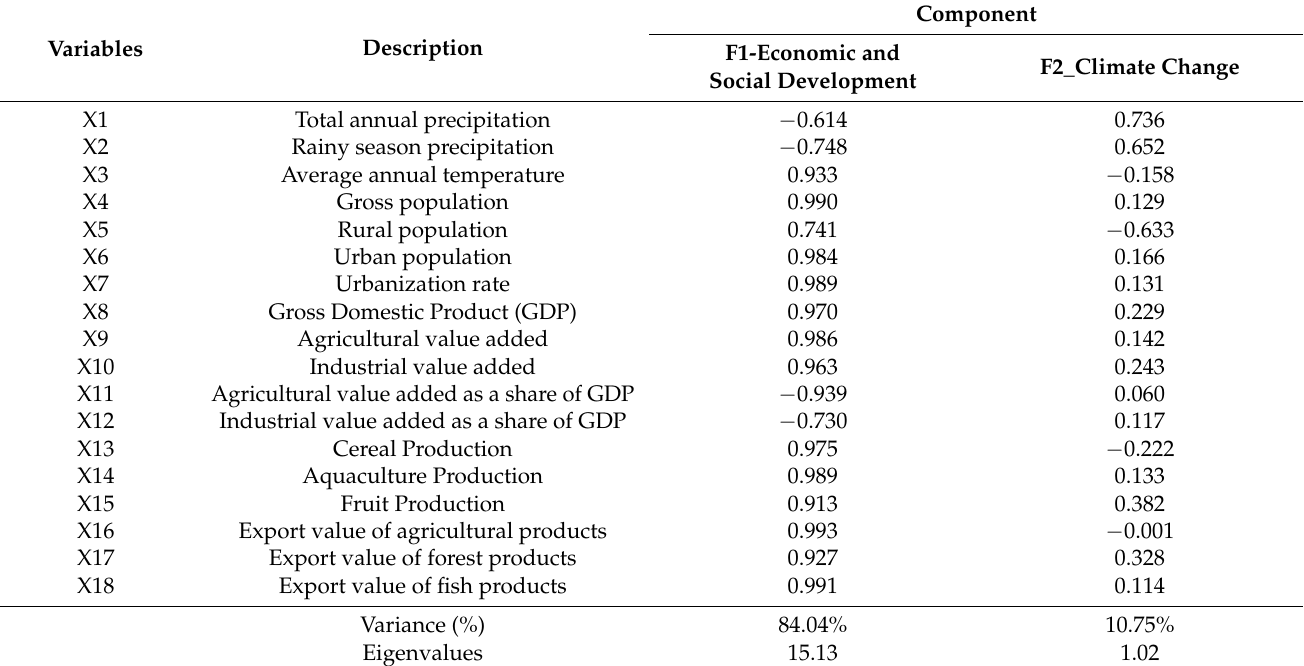
Table 4. Rotated component matrix of the PCA.